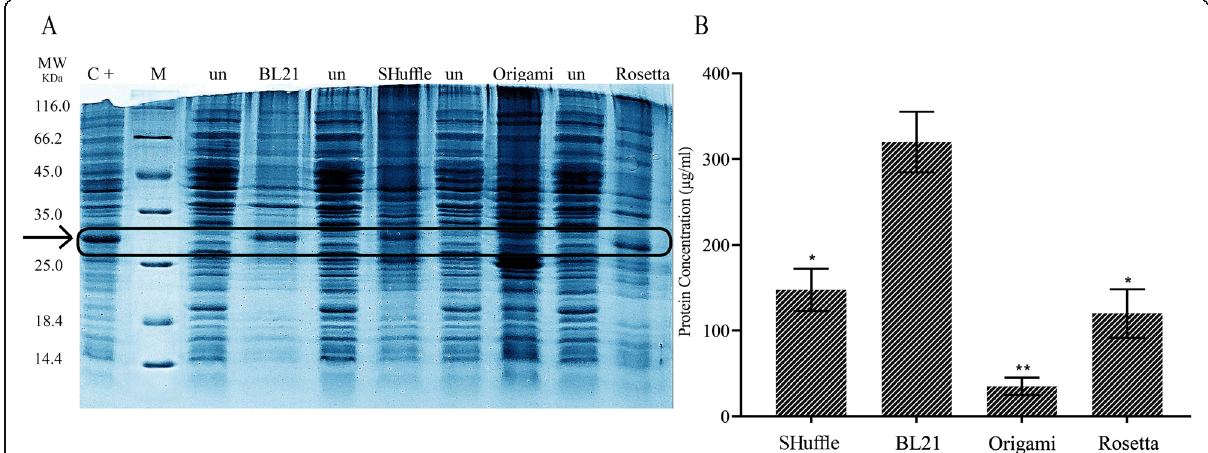
Fig. 1 Expression analysis of the antiEpEX-scFv protein using SDS-PAGE. a The expression level of the target protein was examined in four E. coli strains. The negative control was cells harboring the corresponding plasmid but without induction and the positive control was E. coli K-12 BW25113 cells harboring the corresponding plasmid and were inducted by 0.8 mM IPTG at 37 °C for 24 h (C+)(M: protein marker). b Protein concentration was quantitatively analyzed using BCA. Results showed that the expression levels were lower in E. coli Rosetta TM T7, E. coli Origami TM (DE3) and E. coli SHuffle TM (DE3) compared with E. coli BL21 TM (DE3). Data were analyzed by unpaired, two-tailed Student ’ s t test and